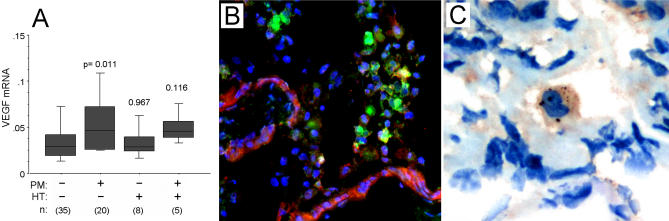
Placental VEGF Expression and Localization in First-Time Mothers(A) Placental VEGF mRNA abundance (median [IQR]) in first-time mothers. Levels indicate fold-increase over trophoblast-specific cytokeratin 7 (KRT7) mRNA.(B and C) Visualization of VEGF in placental cryosections from first-time mothers with intervillous inflammation (B) by immunofluorescence with VEGF (green), trophoblast (red), and nuclear DNA (blue) labeling, 320X magnification, and (C) by immunohistochemistry using DAB and counterstained with Giemsa, 400X magnification.